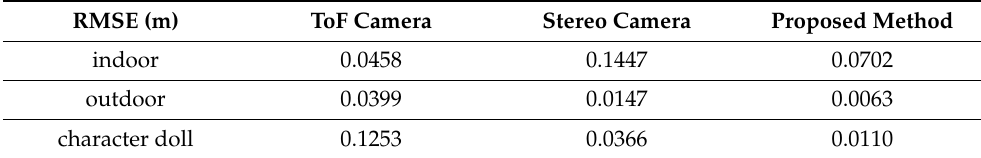
Table 2. RMSE of reconstructed scene by various